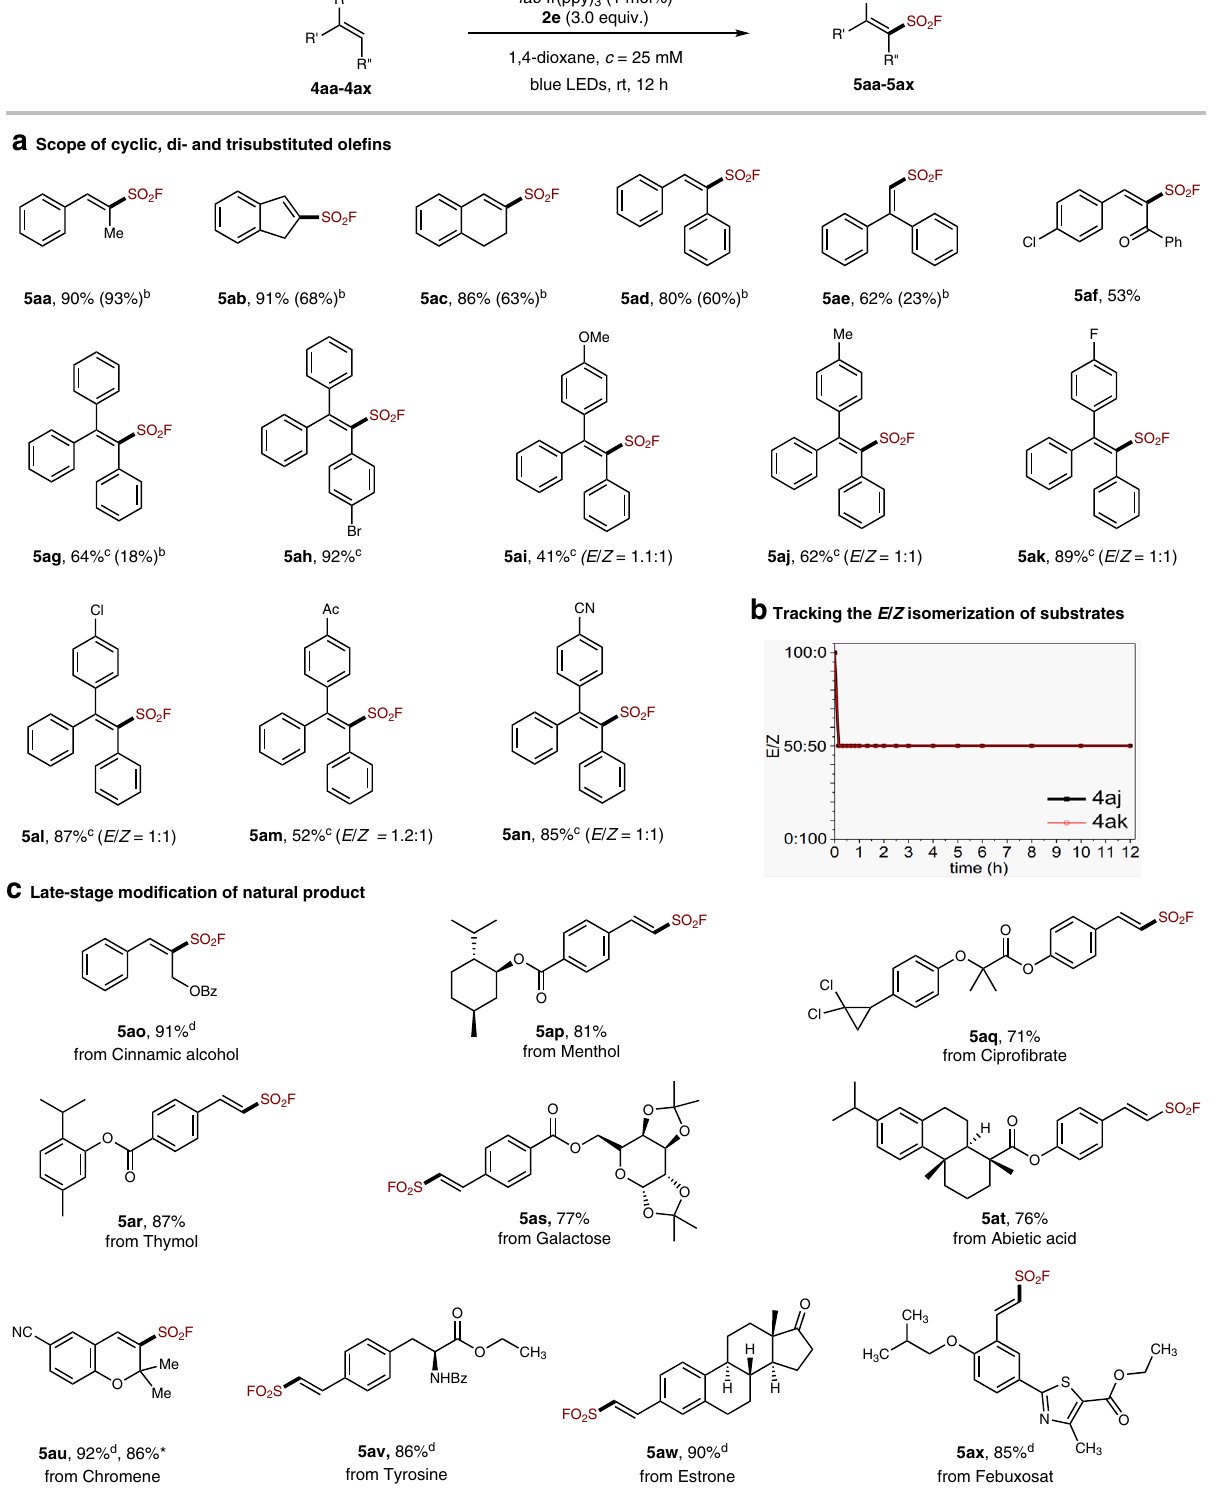
Fig. 4 The scope of multi-substituted ole fi ns and late-stage modi fi cation of natural products. a Scope of cyclic, di- and tri-substituted ole fi ns. b Tracking the E / Z isomerization of substrate 4aj and 4ak . c Late-stage modi fi cation of natural products. a All reactions were performed on 0.1 or 0.2 mmol scales . b In parentheses are yields with FSO 2 Cl. c With 1.0 eq. of K 2 CO 3 . d With 2.0 eq. of 2e . *Reactions on 1.0 mmol